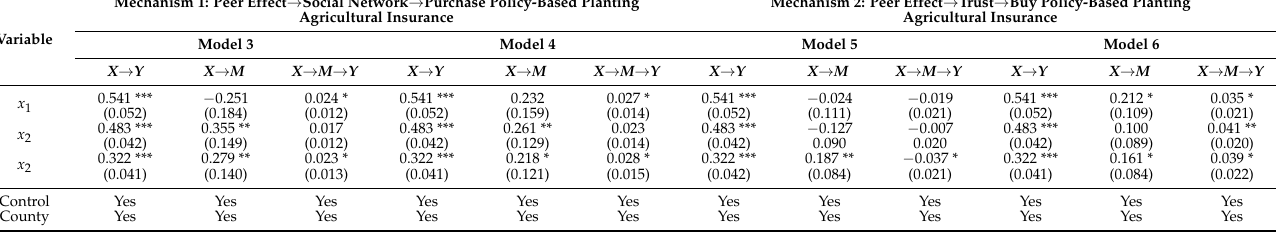
Table 4. Mechanism